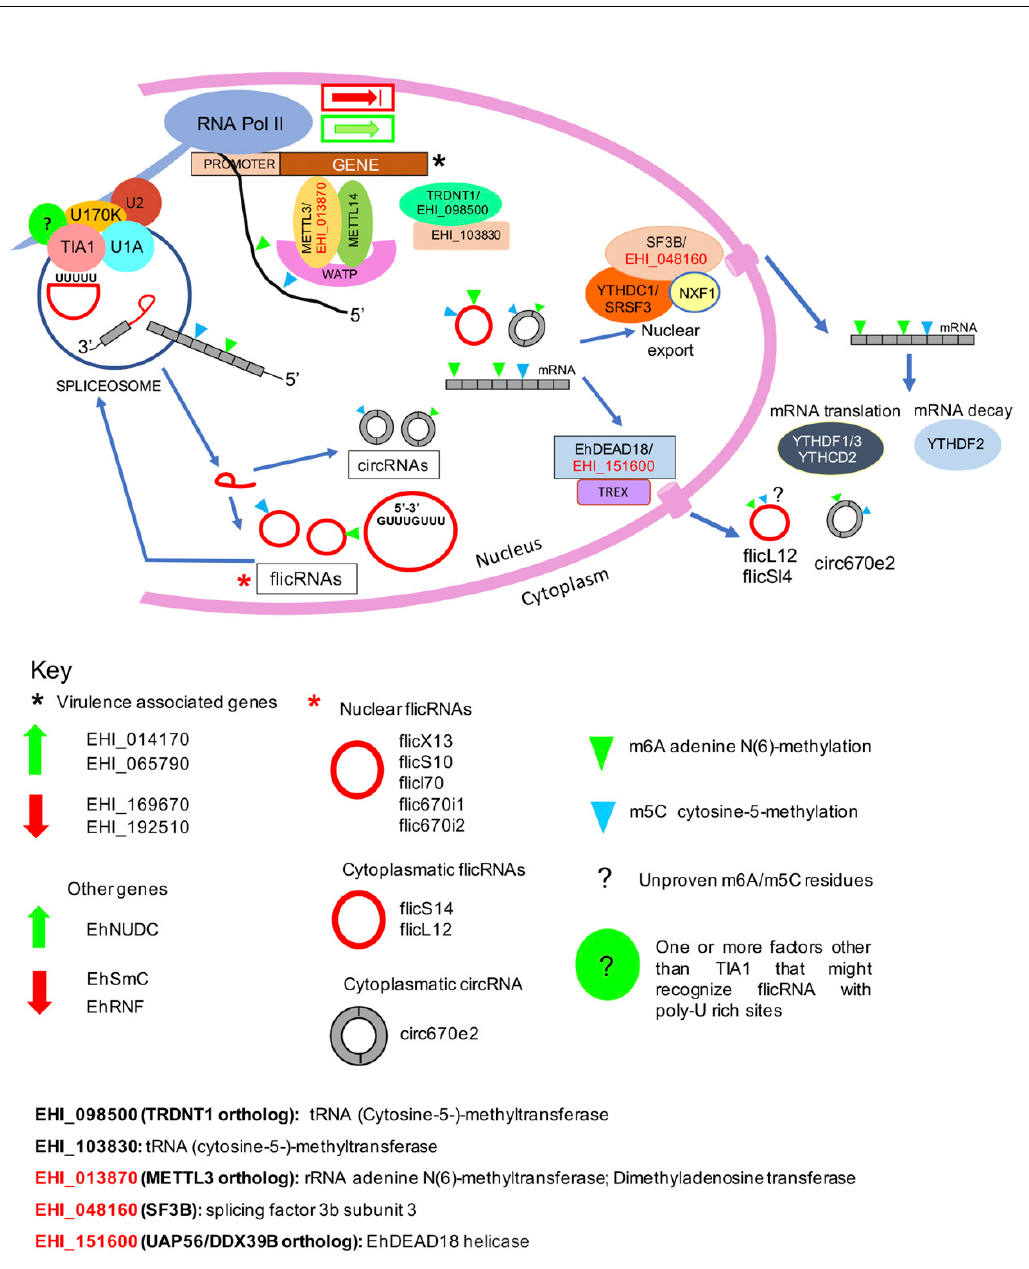
Figure 5. Entamoeba histolytica mRNA and circular RNA biogenesis, transport, and functions. The model described in the main text depicts our current understanding of the protein complexes involved in each process. Components of the spliceosome previously described in our group [31]. Putative methylases and nuclear export proteins that have been previously identified by proteomic analysis of pre-messenger ribonucleoparticles are highlighted in red. Activation/silencing (green upwards/red downwards arrows, respectively) of virulence-related and nuclear gene transcripts (black asterisk) are indicated, as well as the flicRNAs (red asterisk) described here. Green and blue arrowheads indicate adenine N6-methylation and cytosine-5-methylation, respectively. The question mark denotes unproven methylation events. A green bubble with a question mark represents additional factor(s) facilitating flicRNA-spliceosome-Pol II-CTD interaction involved in transcriptional regulation.